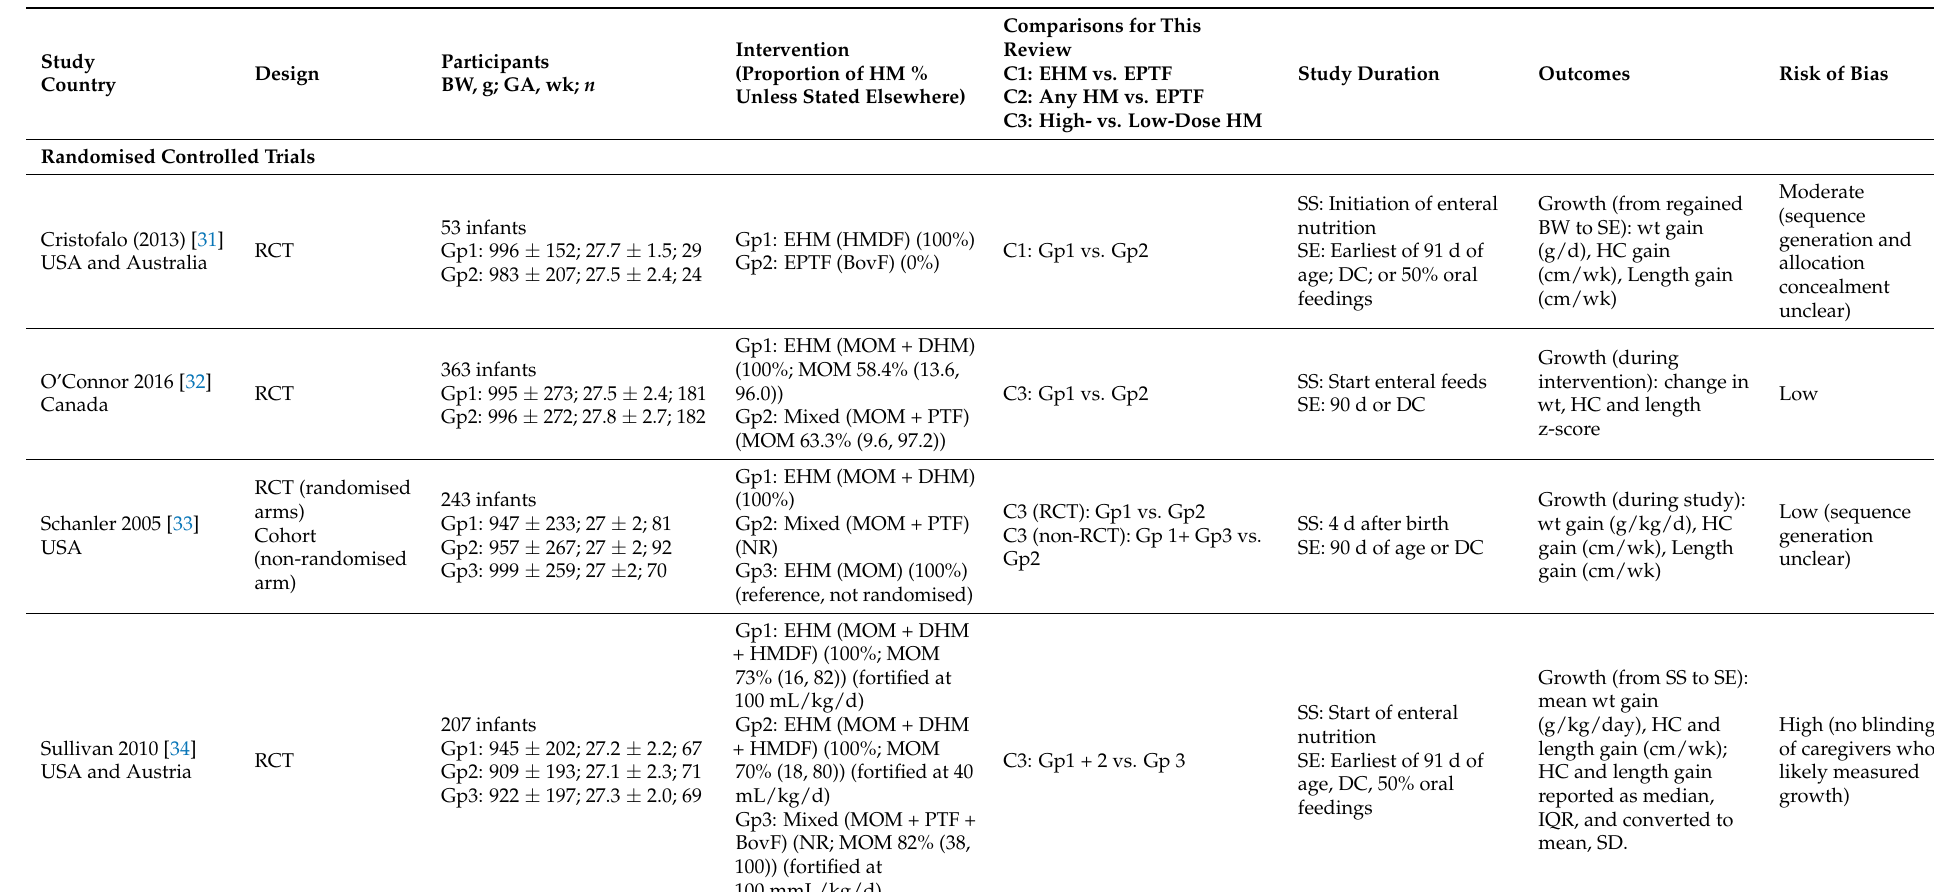
Table 1. Characteristics of included